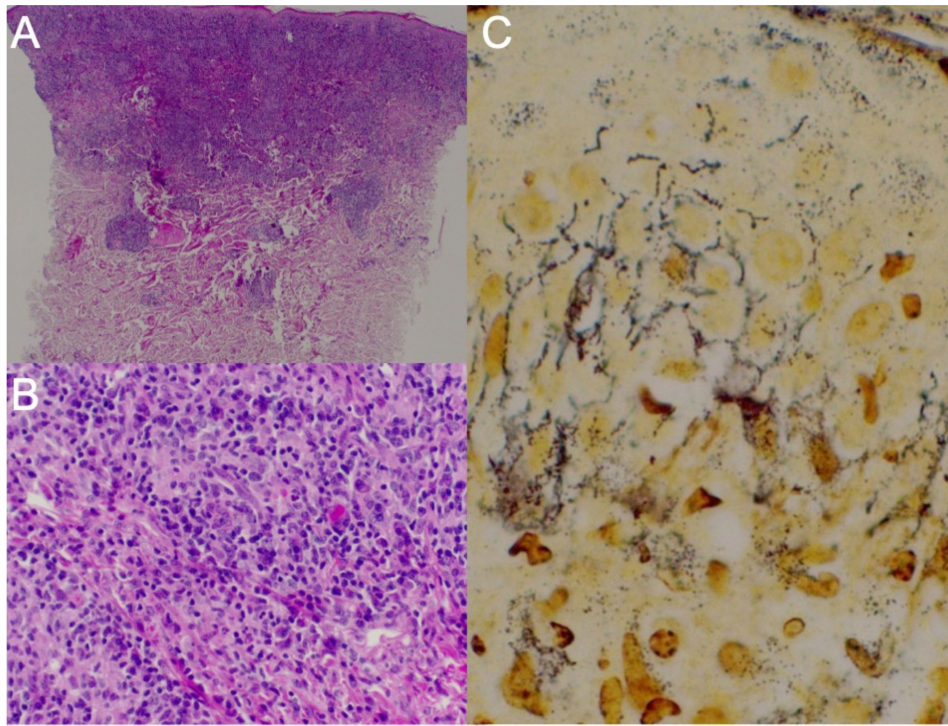
Figure 2. Histopathology analysis of biopsy specimens of a patient with secondary malignant syphilis. ( A , B ) Suprascapular skin biopsy sample under low ( A ) and higher ( B ) magnification. Within the superficial and mid dermis is a dense, diffuse inflammatory infiltrate composed mainly of atypical T-cells, numerous plasma cells and histiocytes. ( C ) Facial skin biopsy: Warthin–Starry staining identified